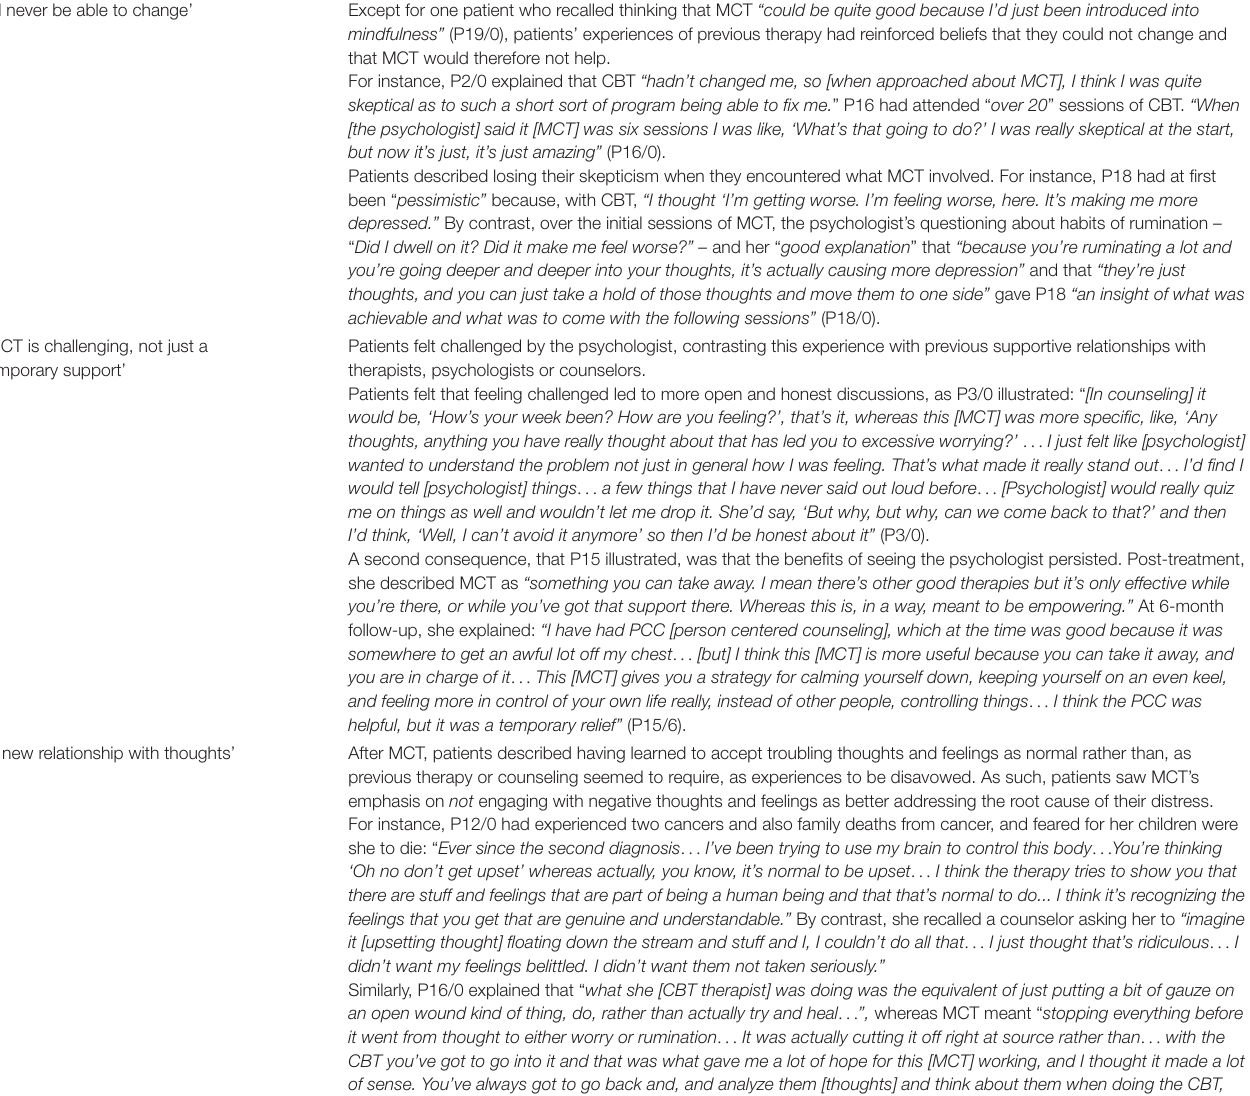
TABLE 2 | Patients’ accounts of how MCT compared with therapy that they had received